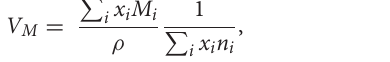
FIGURE 2 | Relationship between the activation energies of solubility E s and diffusivity E D for He, Ne, Ar, H 2 , and D 2 of silica, alkali silicate, lead silicate, alkali-alkaline earth silicate, borosilicate, aluminoborosilicate, and aluminosilicate glasses. Data: (Shelby, 1973, 1974a, 1996; Shelby and Eagan, 1976; Ried et al.,